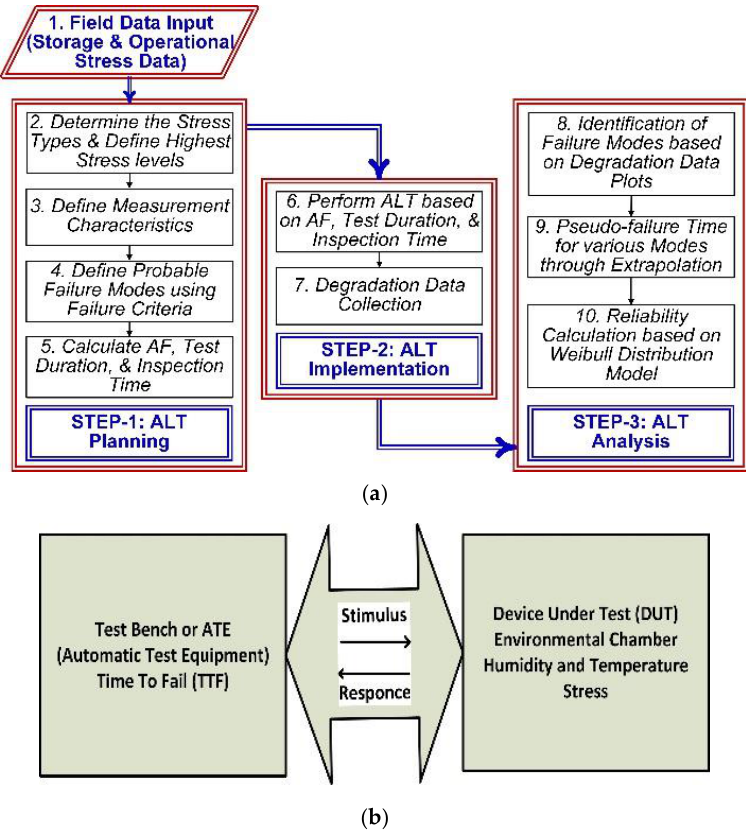
Figure 2. The proposed methodology for the remaining useful life (RUL) and reliability calculations. ( a ) Methodology and process flow diagram; ( b ) experiment procedure block diagram .